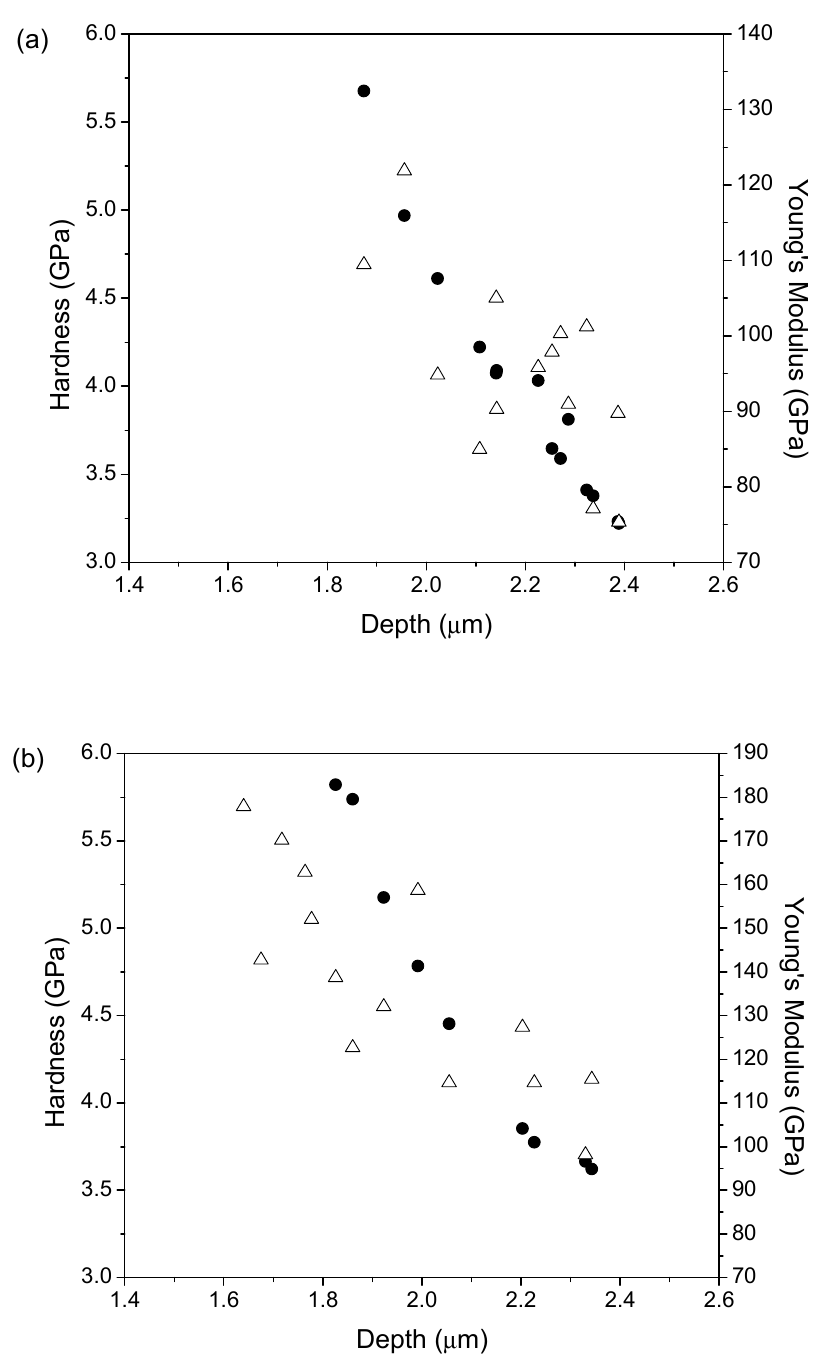
Figure 5. Hardness (black circles) and Young’s modulus (white triangles) of the titanium samples coated with TiN ( a ) 1 mm and ( b ) 0.5 mm grid.